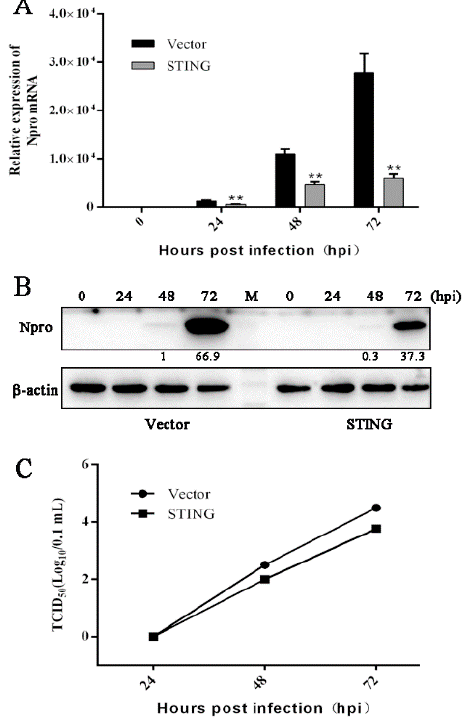
Figure 4. The PRRSV replication in porcine macrophages transfected with porcine STING. ( A-C ) CD163-PAMs seeded in 24-well plates were transfected with porcine STING or vector pmCherry-C1 (0.25 μ g each) using lipofectamine 2000. At 24 h post transfection, the cells were infected with PRRSV at a MOI of 0.1, for 0, 24, 48, and 72 h, respectively. The infected cells were then assayed by RT-qPCR ( A ), Western blotting ( B ) and TCID50 assay ( C ). ** p < 0.01 versus the vector control groups. The values of PRRSV N protein (Npro) quantification by gray scanning were shown below the bands following normalization by β -actin.